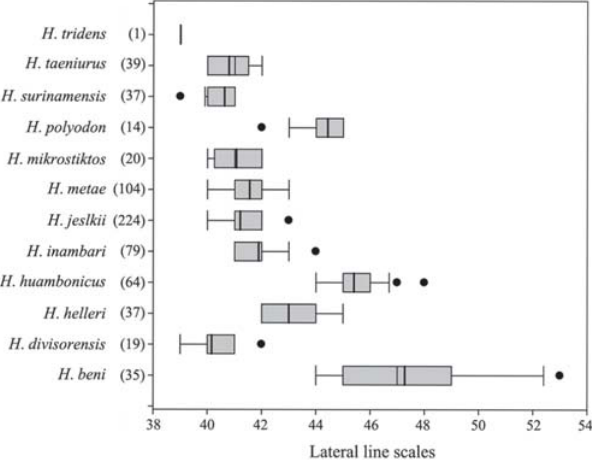
Fig. 2. Tukey box plots of number of branched anal-fin rays in Hemibrycon species. Mean represented by thick vertical bar, and 25 th and 75 th percetiles as lateral borders of box plots. Number in parentheses = N.